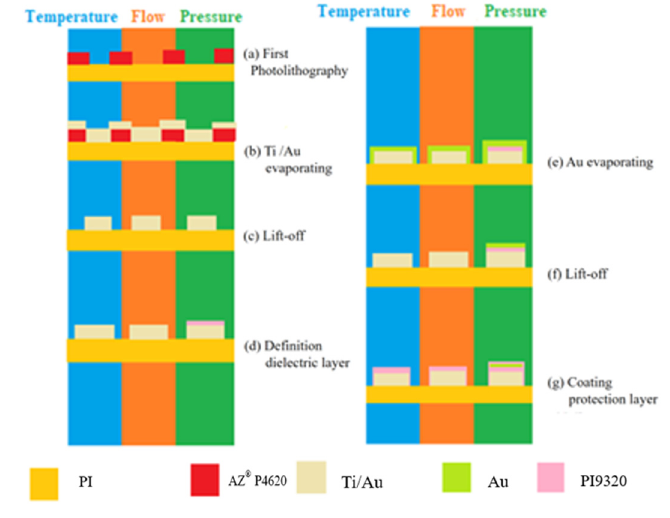
Figure 1. Process diagram of a three-in-one flexible micro-sensor.